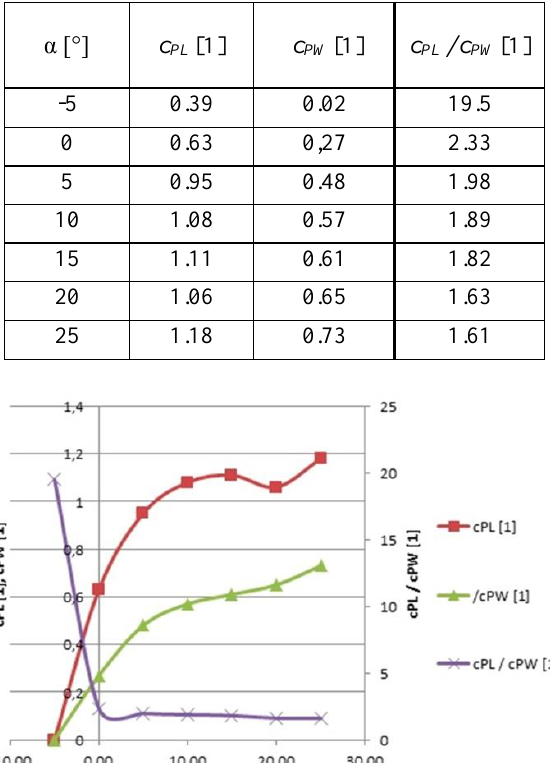
Fig. 6. Lift coefficient c PL of the airfoil AH93-157 and pressure coefficient c PW on the corresponding walls dependent on the angle of